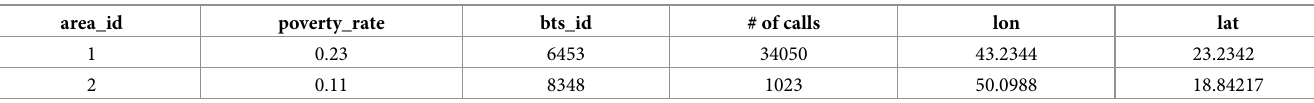
Table 1. Example of statistical data and mobile phone